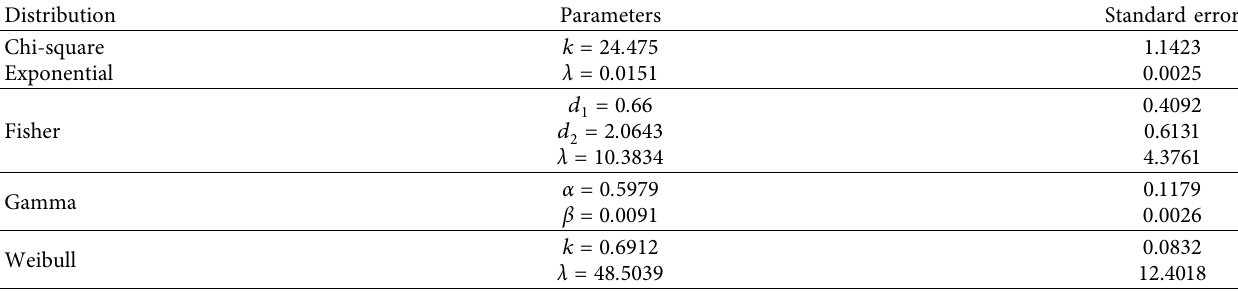
Table 9: Cyber-related data breach loss frequency distribution parameters.